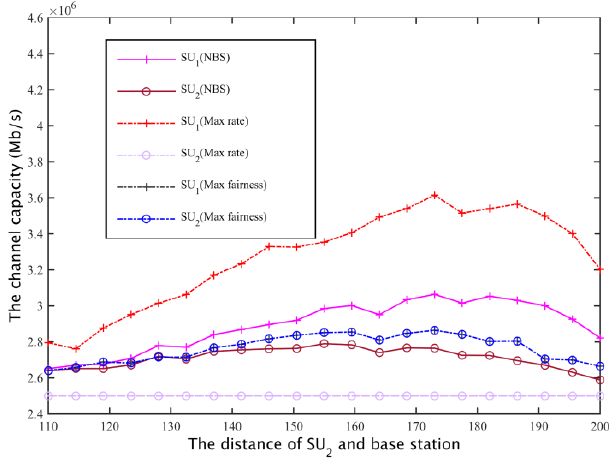
Figure 21. Secondary user channel capacity comparison II.